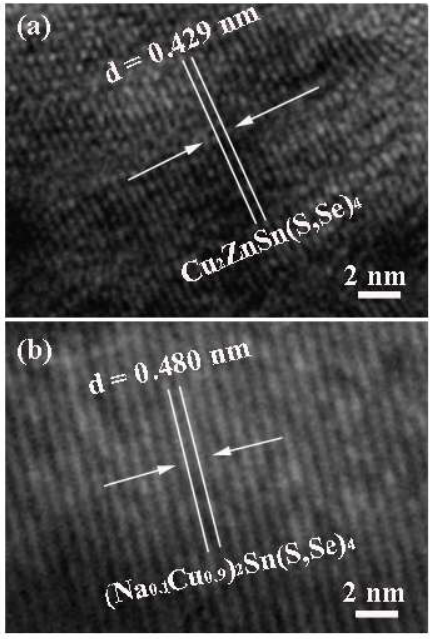
Figure 4. High-resolution TEM images of ( a ) Cu 2 ZnSn(S,Se) 4 and ( b ) Na-doped Cu 2 ZnSn(S,Se) 4 films selenized at 540 °C.